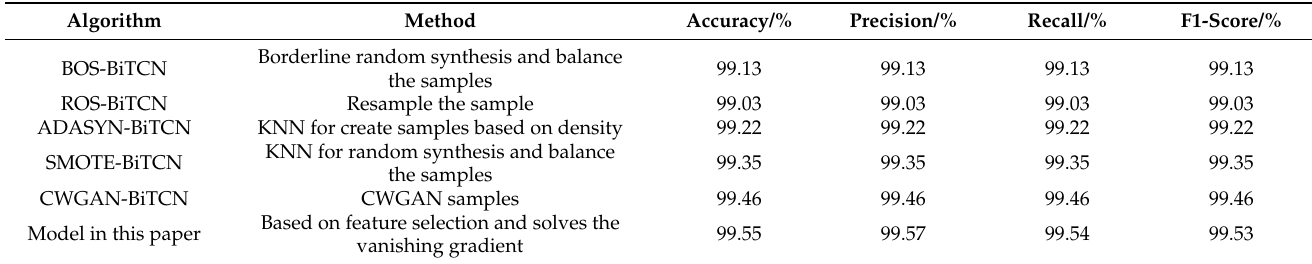
Table 5. Detection results under the influence of enhanced algorithms on Kaggle dataset.